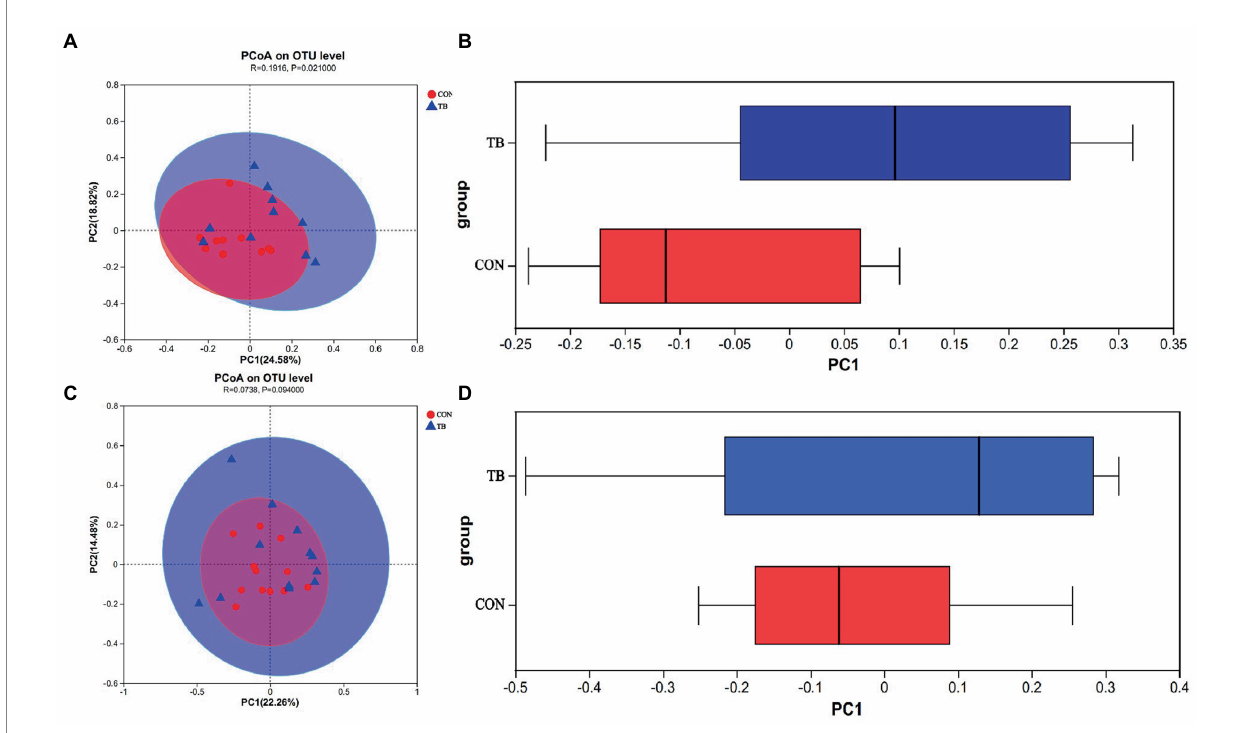
FIGURE 4 Effects of tributyrin on the fecal microbes of sows (A,B) and piglets (C,D) . Principal coordinate analysis (PCoA) plots show differences between the CON and TB groups. Red circles indicate the CON group, blue circles the TB group, and the closer the two samples are, the more similar the composition of the two species (A,C) . Boxplots represent the distribution of different groups of samples on the PC1 axis. (B,D) R -value is scaled to lie between − 1 and +l. Generally, 0 < R < 1 and p < 0.05 represents that there were significant differences between the groups.